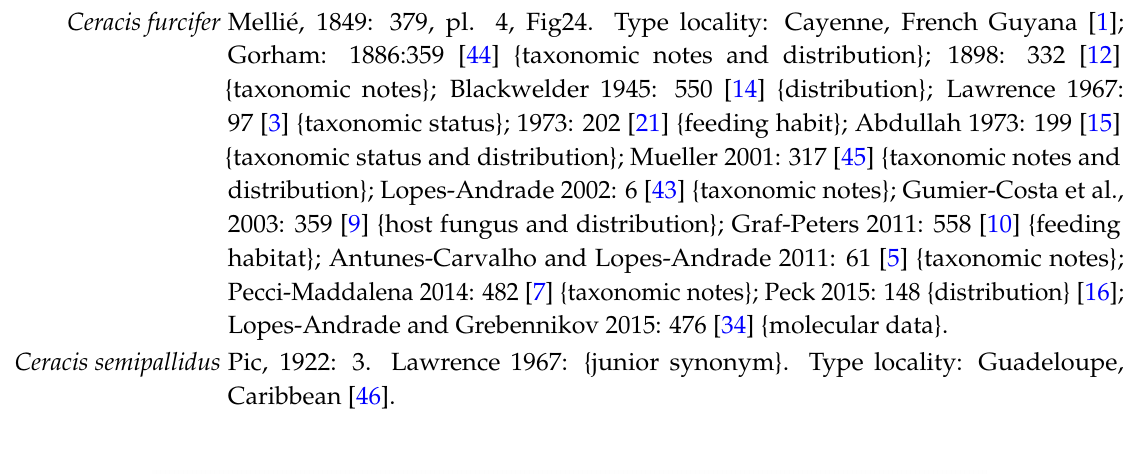
Figure 1D; Figure 5I,J; Figure 7A–F; Figure 8 and Figure 11.4. Ceracis furcifer Melli é , 1849: 379, pl. 4, Fig24. Type locality: Cayenne, French Guyana [1];